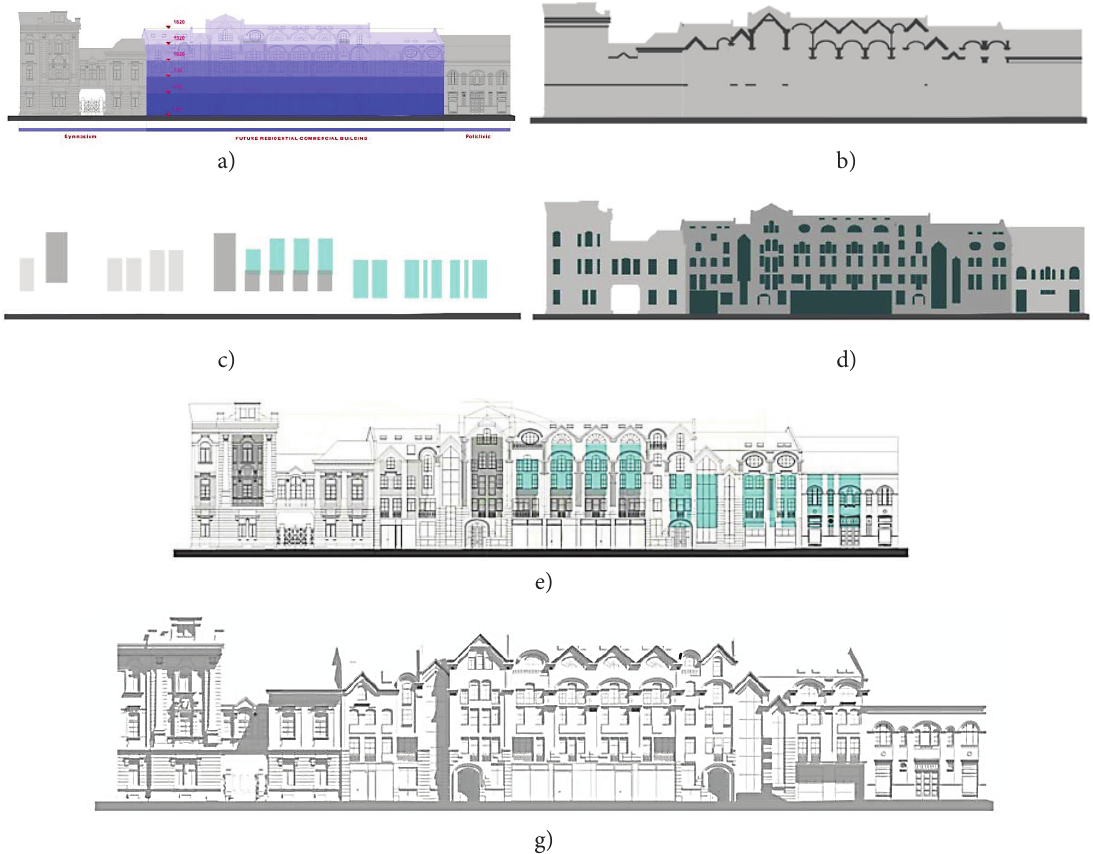
Figure 8. Morphological analysis of the facade in the historic environment. Petefi Sandor Street view. Polyclinic building on the right, Gymnasium on the left (source: Design proposition by author, 2016); a) Installation of the vertical levels of facade spots; b) analysis of the building cornice line; c) Vertical rhythms (light gray – Gymnasium rhythms, dark gray – proposal rhythms, blue – Policlinic rhythms); d) Horizontal rhythms – window rows; e) Proportions on the façade masses; g) Shadows (the plasticity of the